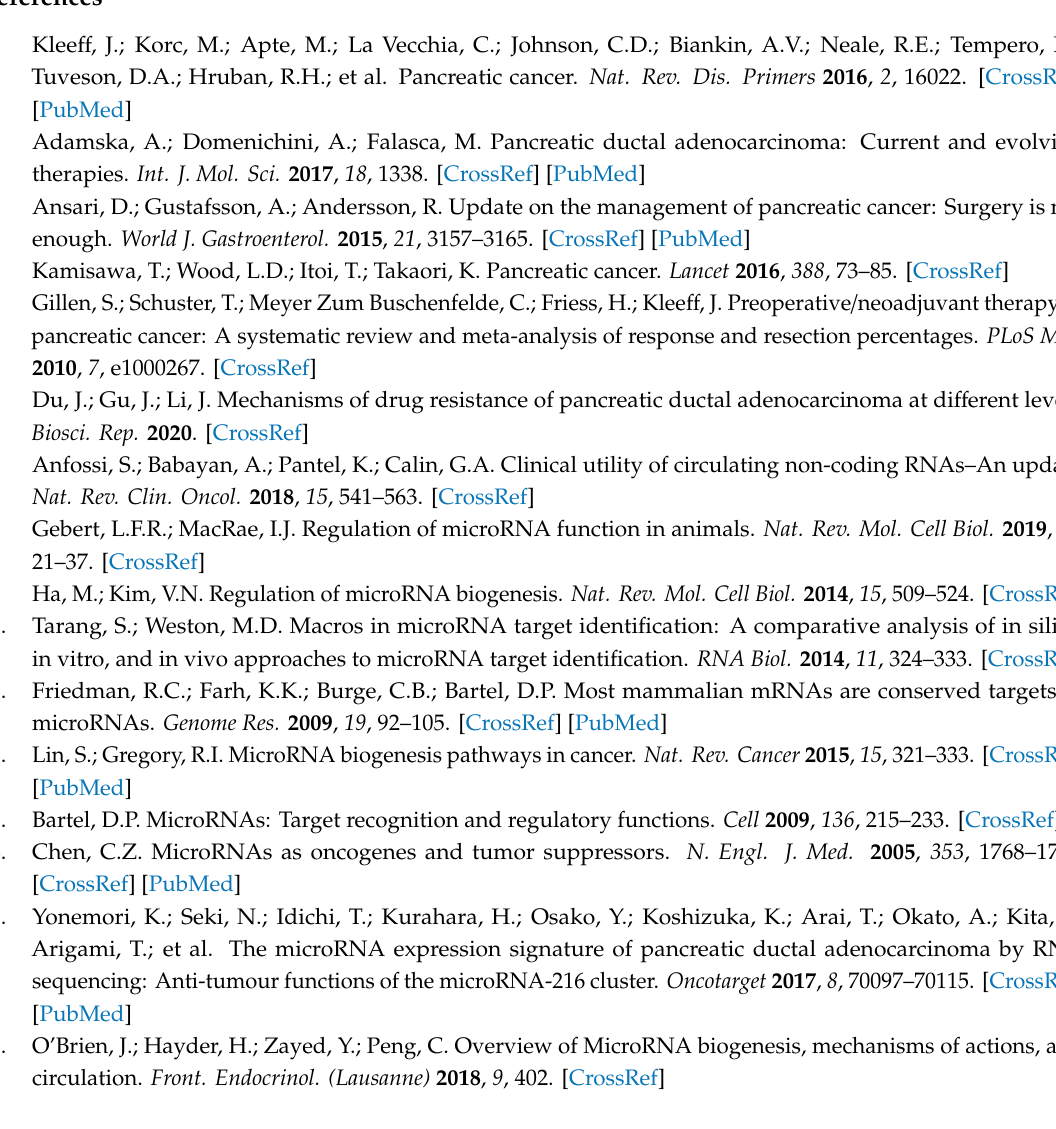
Table S1: Clinicopathological characteristics of the clinical specimens, Table S2: Reagents used in this study, Figure S1: Molecules predicted to be closely related with ITGA2 by Ingenuity Pathway Analysis (IPA), Figure S2: IPA of the canonical pathways for ITGA2 related molecules. Colored molecules are predicted to be associated with the migration of cells, Figure S3: IPA of the canonical pathways for ITGA2 related molecules. Colored molecules are predicted to be associated with the invasion of